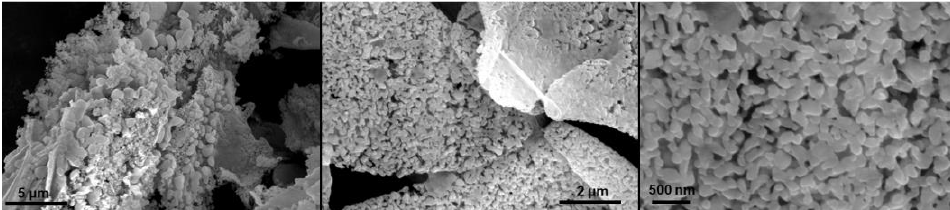
Figure 5. SEM images of powdered product.